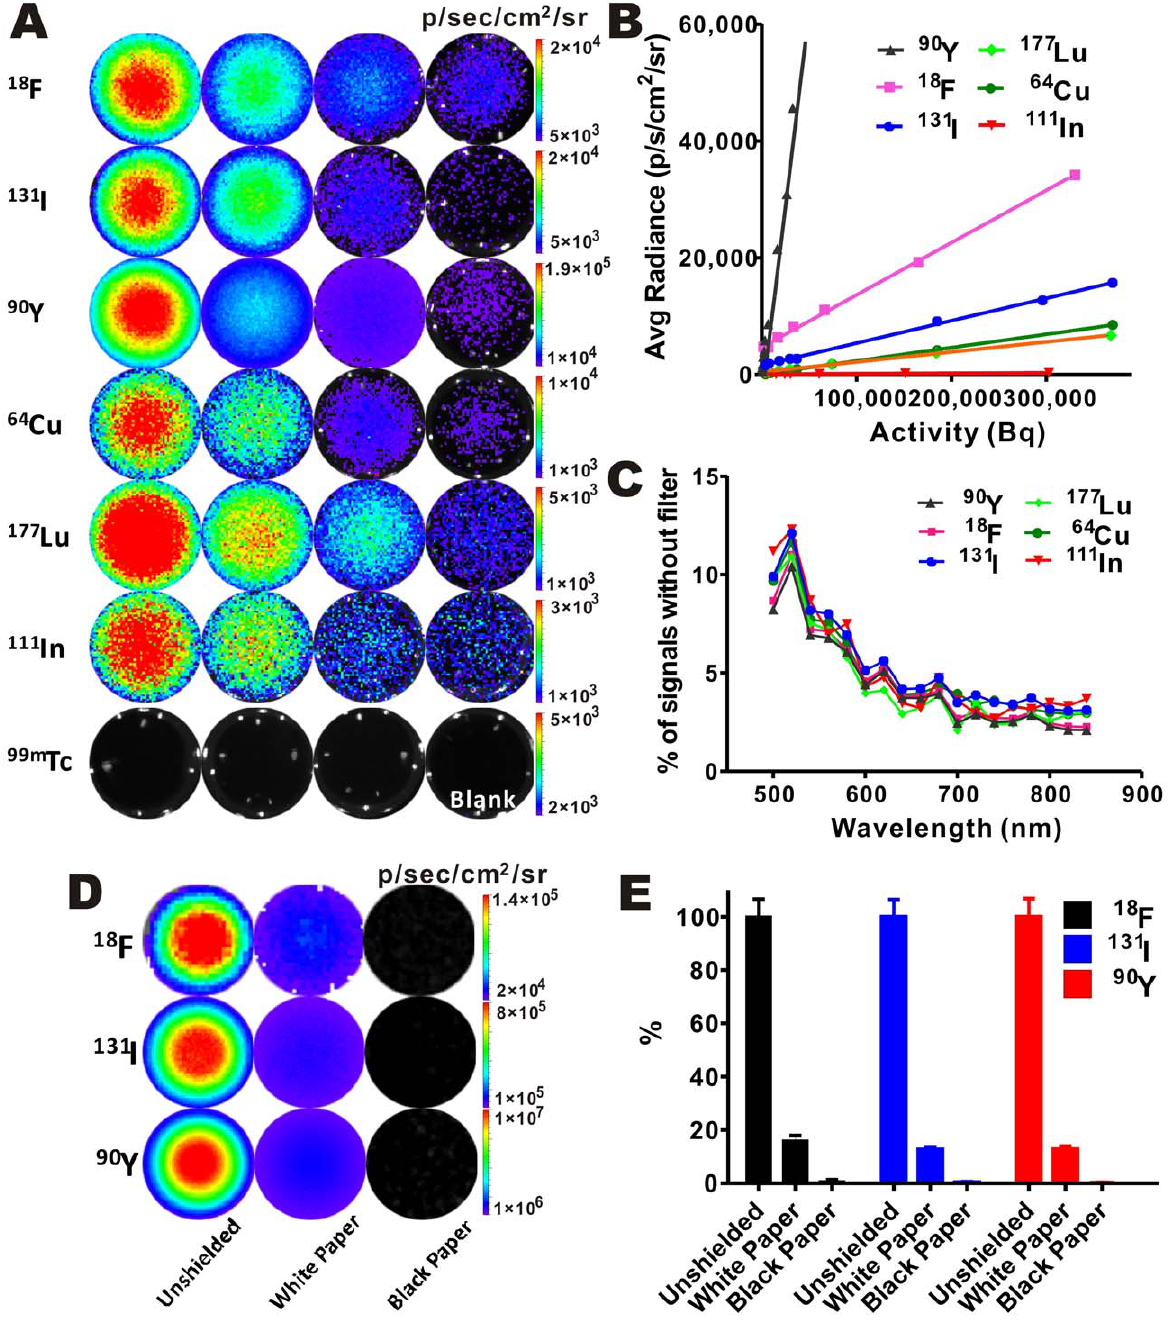
Figure 1. Optical signals are detectable by OI instruments and have a continuous spectrum. ( A ) Most nuclides, except 99m Tc, provide OI signals with sensitivity within as low as 0.004–0.370 MBq (0.1–10 m Ci) range. ( 18 F: 5, 2, 1, 0.1 m Ci; 131 I: 10, 5, 1, 0.1 m Ci; 90 Y: 5, 1, 0.2, 0.01 m Ci; 64 Cu: 10, 5, 1, 0.1 m Ci; 177 Lu: 10, 5, 2, 0.5 m Ci; 111 In: 10, 5, 1, 0.5 m Ci; 99m Tc: 20, 10, 5 m Ci ). ( B ) Detection sensitivity of different radionuclides. Radionuclides with a higher K value have stronger signal intensity. ( C ) Similar spectra were ovserved from different radionuclides. Results are presented as the ratio of photons detected using a narrow band emission filter (20nm bandwidth) versus total photons detected without a filter. ( D, E ) Shielding tests ( D ) and quantification analysis of imaging signals ( E ).